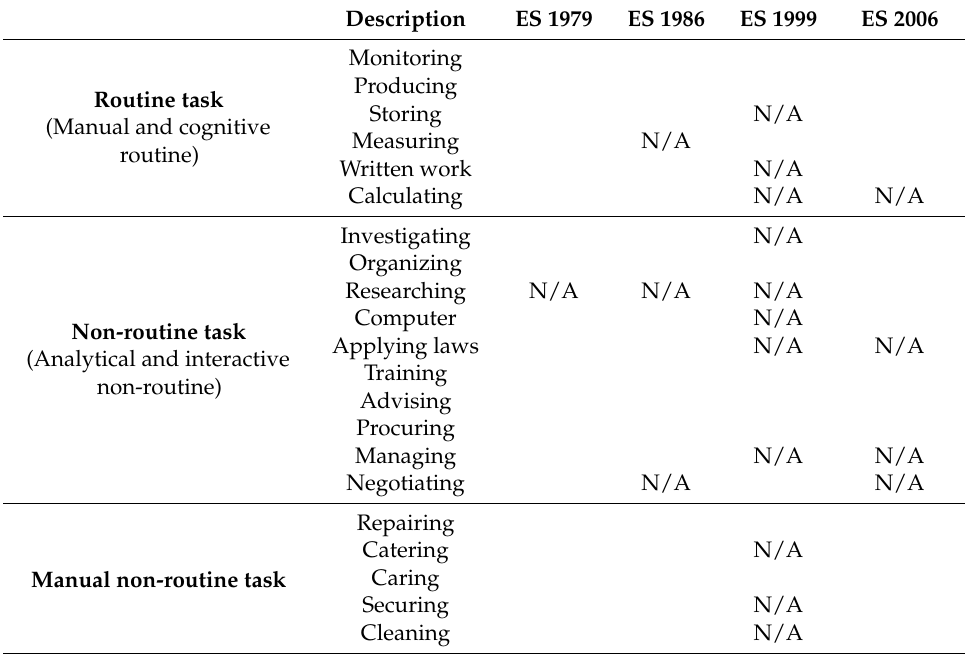
Table 1. Alignment of task items of the 2006 Employment Surveys (ES) to the categories of the task-based